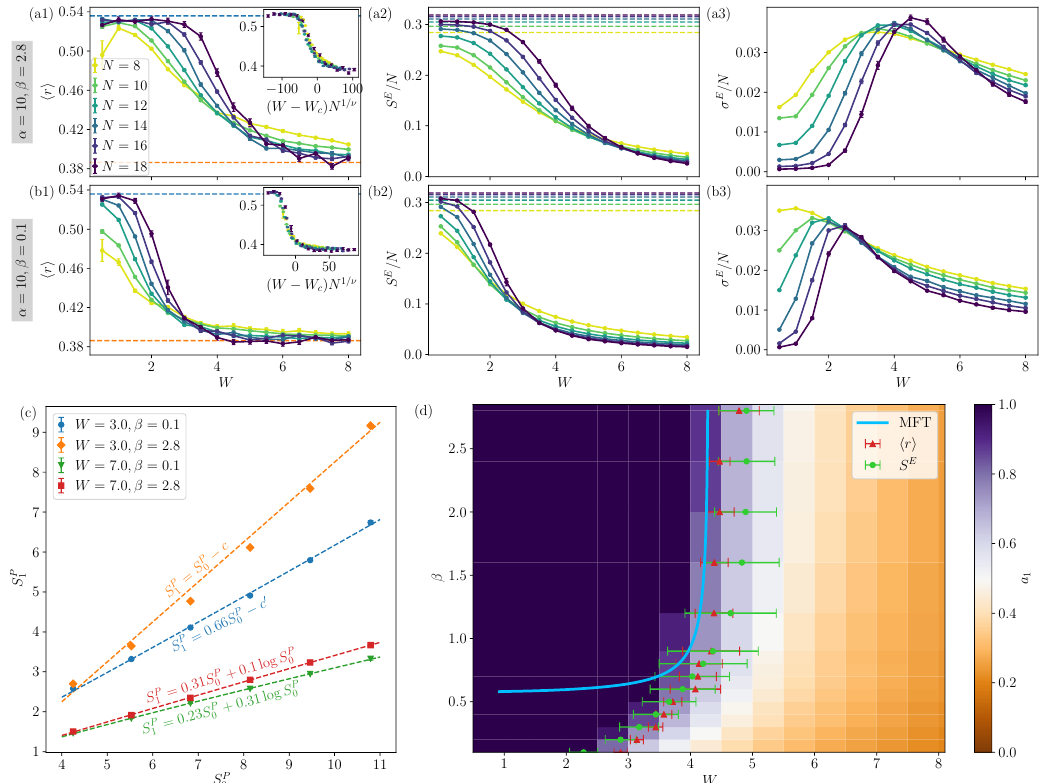
Figure 4: Numerical phase diagram in a constant- α plane: Figure is analogous to Fig. 3, but with a constant α = 10. Top two rows show data as a function of disorder strength, W , for two values of β = 2.8 (panels (a1)-(a3)) and β = 0.1 (panels (b1)- (b3)). In the 〈 r 〉 data there is an apparent crossing for both values of β , but W is c clearly smaller for β = 0.1 than β = 2.8. Data for S E / N and σ E / N convey the same message, again showing that W decreases for smaller β . Panel (c) shows the the c = log N vs S P first participation entropy S P , for two representative values of W and H 1 0 < 1 for both two values of β . For large enough disorder, e.g. W = 7 in the figure, a 1 (cid:39) 1 values of β , indicating a many-body localised phase. However for W = 3, a 1 for β = 2.8, indicating that the system has transited to a delocalised phase,while for β = 0.1, a continues to be < 1, the system thus remaining localised; and again 1 showing that W decreases with decreasing β . The phase diagram in the ( β , W ) - c plane for α = 10 is shown in panel (d). The a values are shown as a colour-map, 1 and the W values extracted from the finite-size scaling analyses of 〈 r 〉 and S E are c indicated; the prediction from mean-field theory is shown by the light blue line. All clearly show that the critical W decreases with decreasing β c